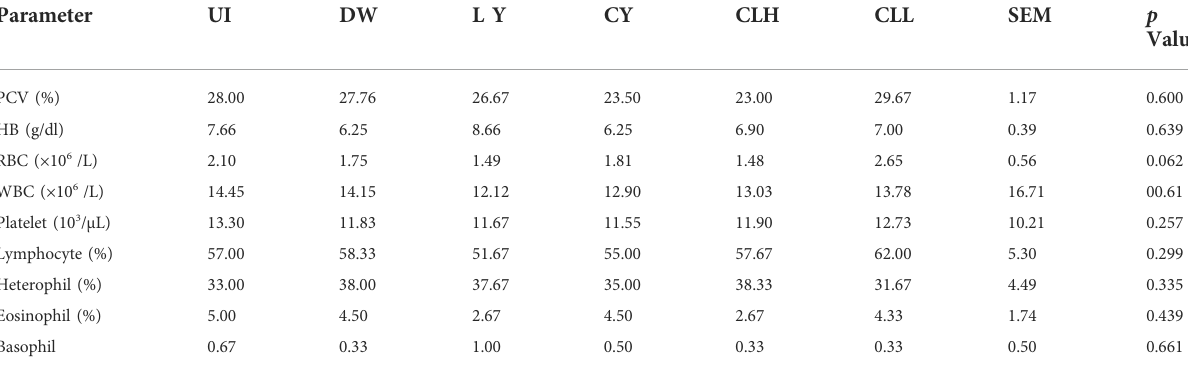
TABLE 5 Effect of in ovo cysteine and lysine on haematology at hatch.